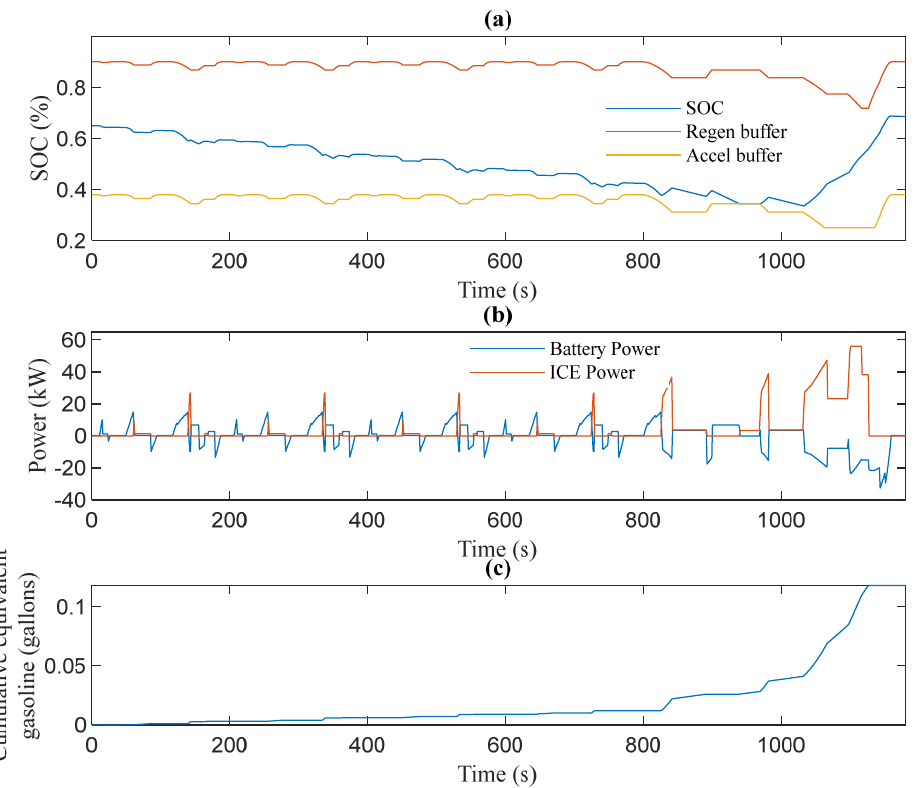
Figure 6. FASTsim simulation results for the HEV of [49] for NEDC cycle. ( a ) Battery SOC; ( b ) powers of the battery and the ICE; ( c ) cumulative equivalent gasoline consumption in gallons.